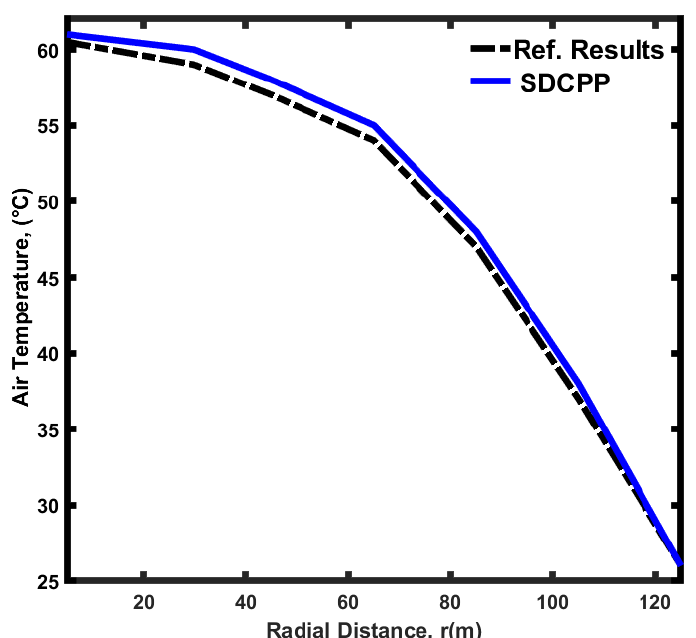
Figure 3. The performance results of the SDCPP validated against the results were reported by Zou et al. [19]. The temperature profile under the collector is shown; the origin point (0, 0) is the center of the chimney, while the entrance of the collector is at 125 m.